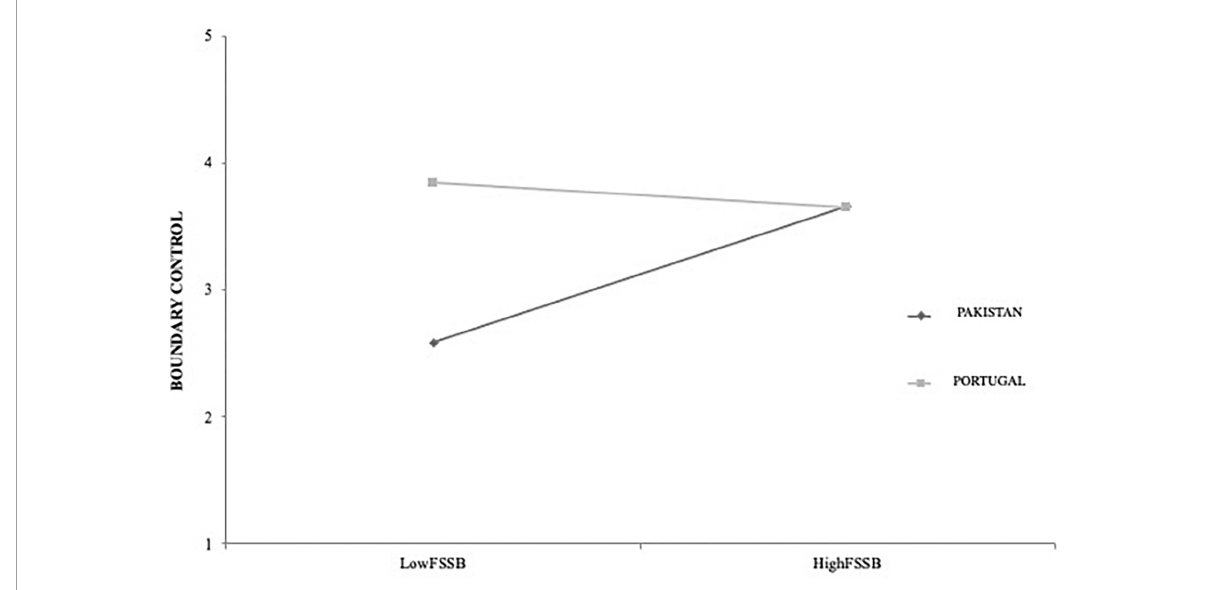
FIGURE1 The moderated role of country in the relationship between FSSB and Boundary